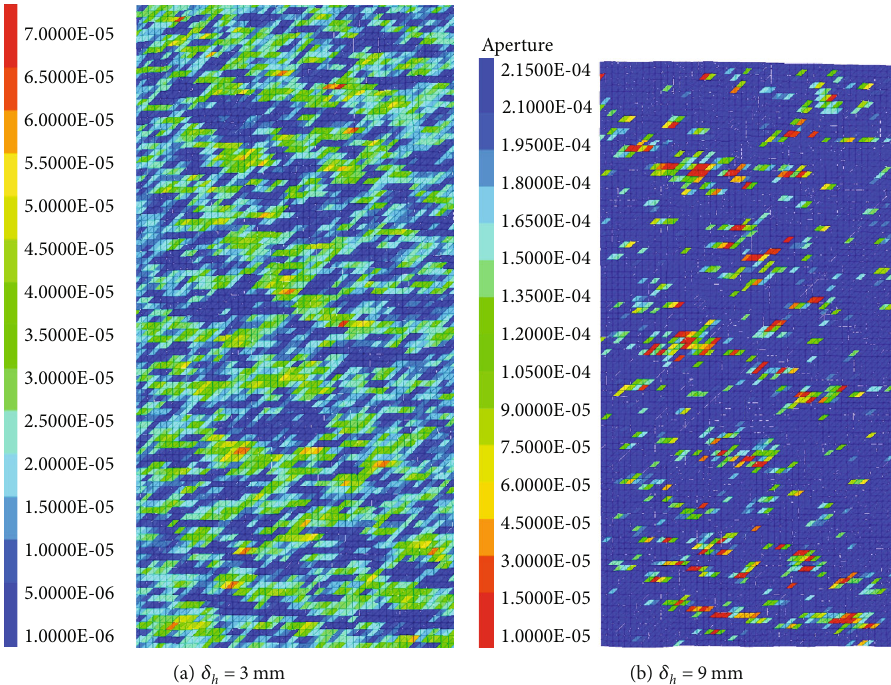
Figure 21: Evolution of hydraulic aperture during